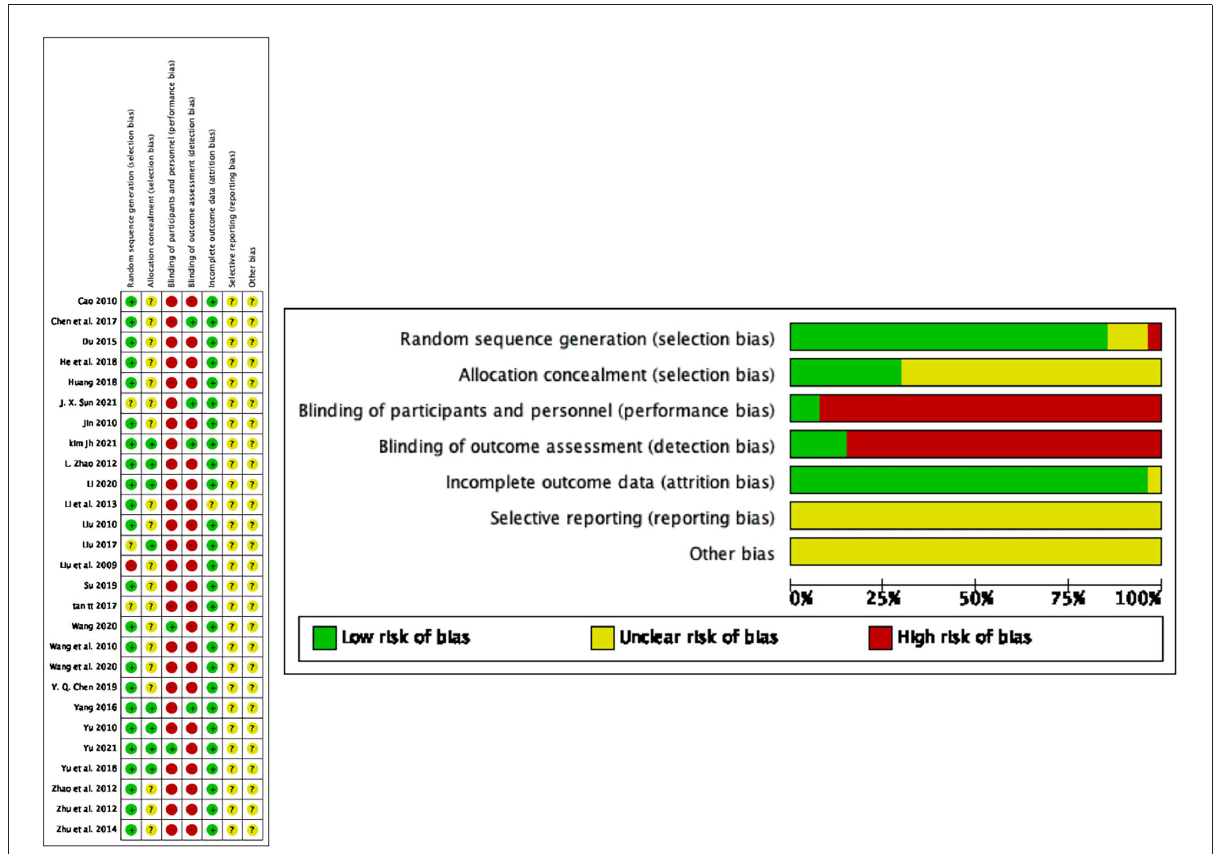
FIGURE2 Risk of bias graph and